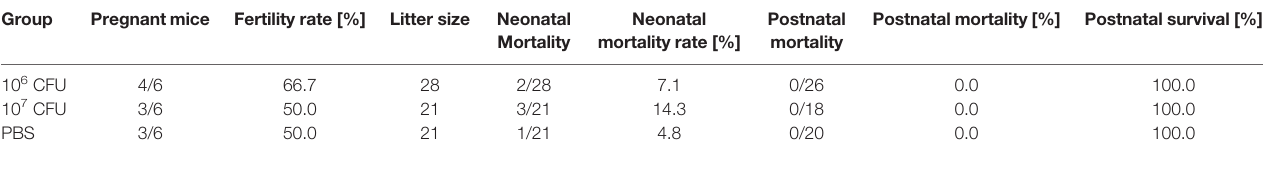
Group Pregnant mice Fertility rate [%] Litter size Neonatal